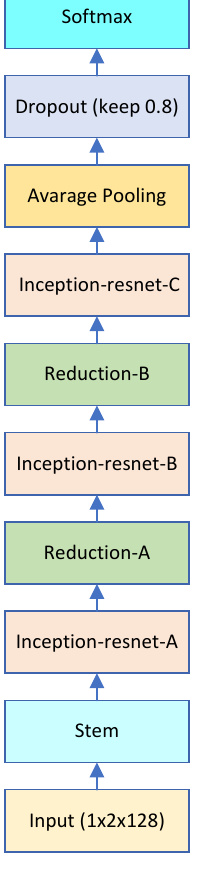
Figure 7. mini Inception–Resnet.